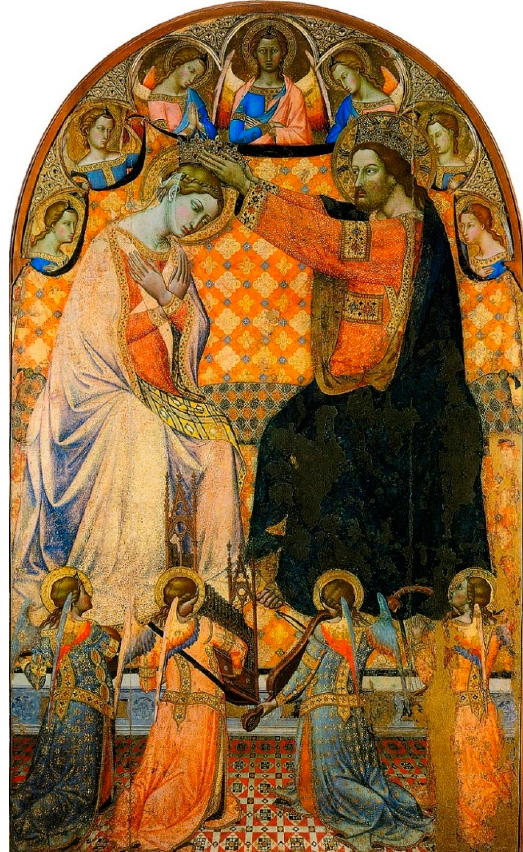
Figure 12. Coronation of the Virgin Mary , pictures by Jacopo di Mino del Pellicciaio (1340s?), Montepulciano, Museo Civico e Pinacoteca Crociani; Wikipedia Commons/public domain.